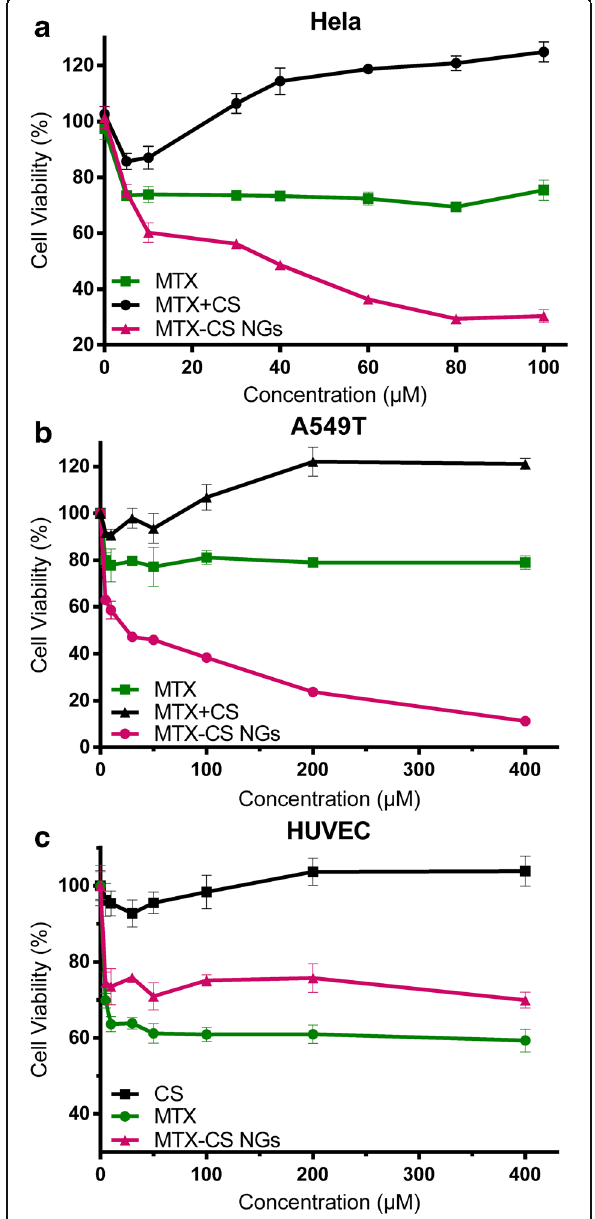
Fig. 5 a Cellular viability of A549 T in the presence of free MTX, free MTX and CS, and MTX-CS NGs in 48 h. b Cellular viability of Hela in the presence of free MTX, free MTX and CS, and MTX-CS NGs in 48 h. c Cellular viability of HUVEC in the presence of free MTX, CS, and MTX-CS NGs in 48